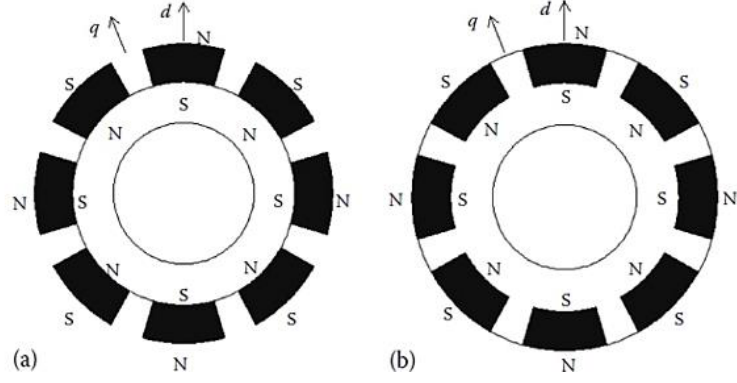
Figure 1. Structure of an SPMSM rotor ( a ) and of an IPMSM rotor ( b ). Two large families of sensorless algorithms can be found in the technical literature.